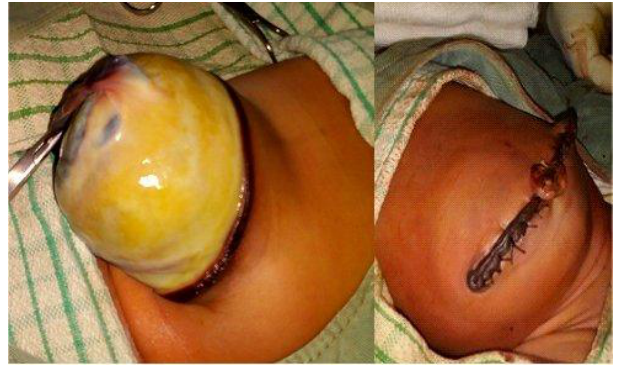
Figure 4: A giant omphalocele and